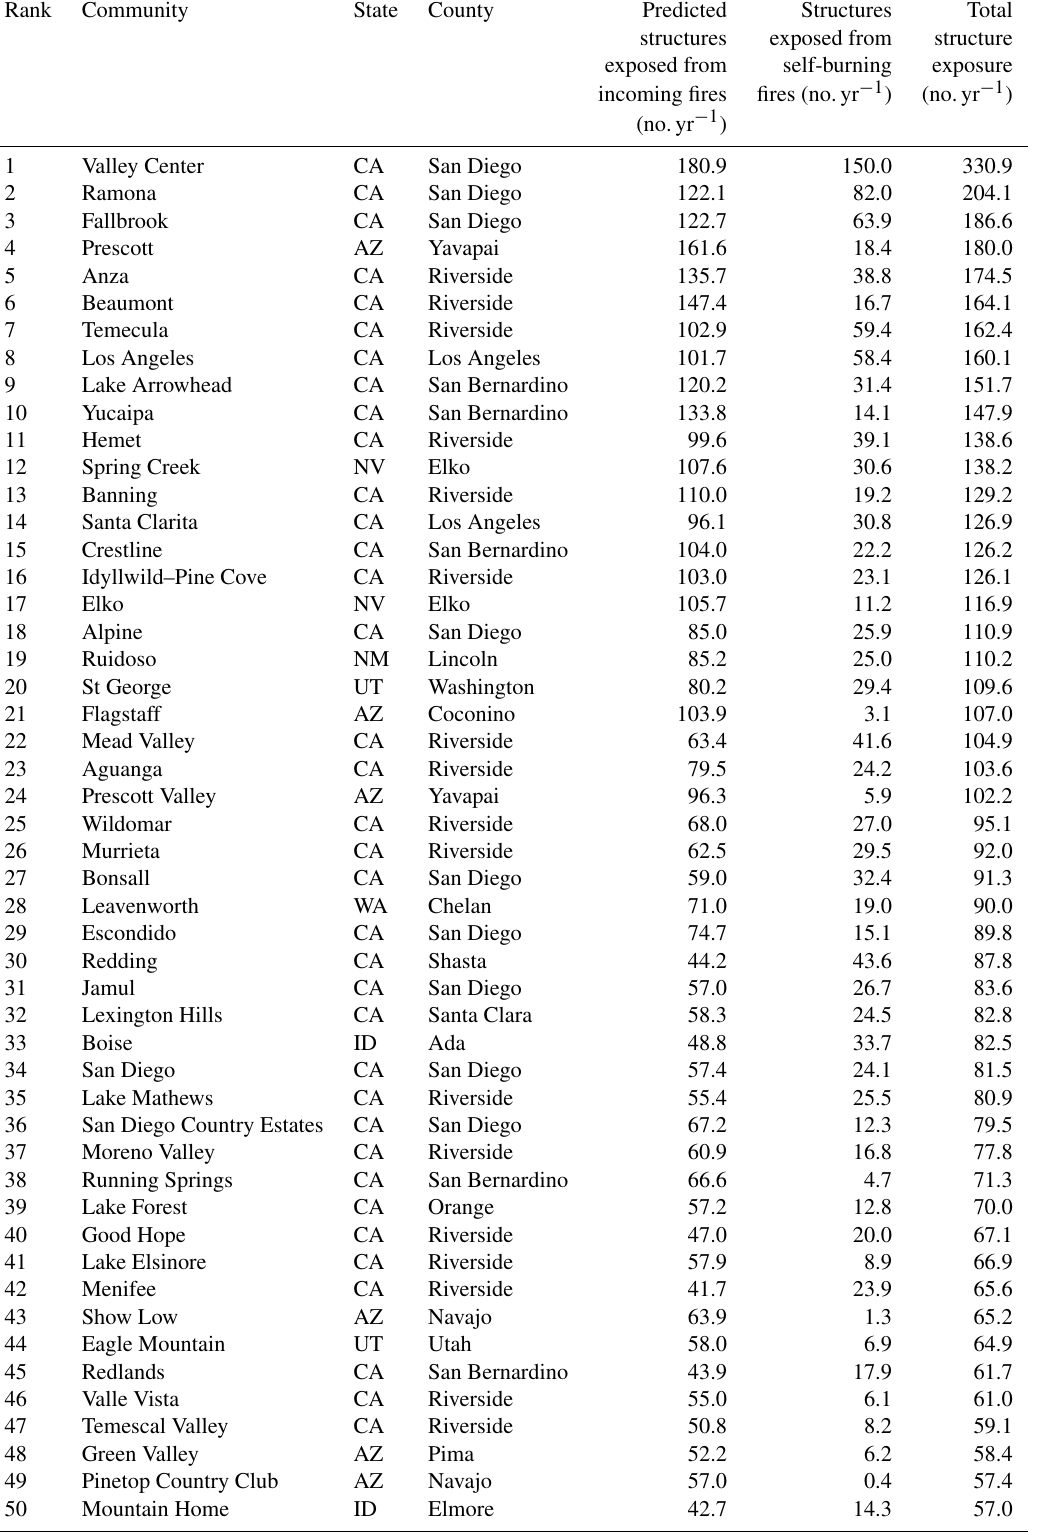
Table B4. List of the top 100 most exposed communities, ranked by the total amount of annual structure exposure (sum of incoming and self-burning